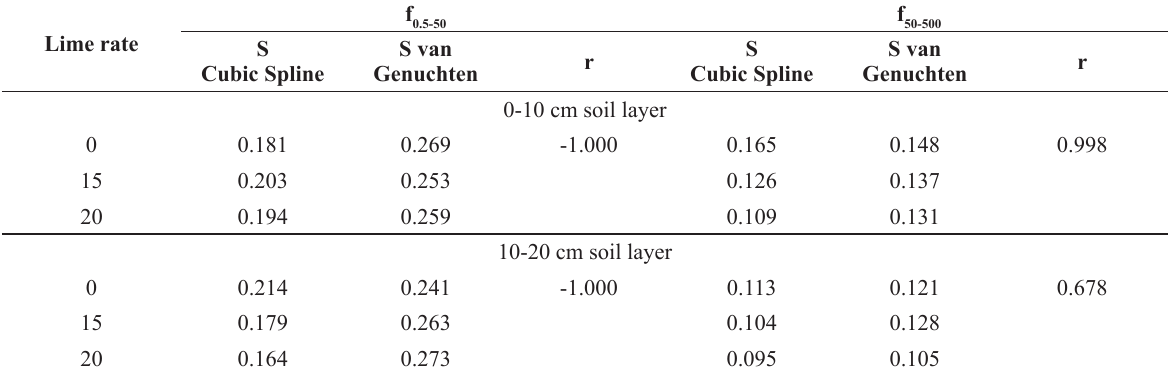
Volume data in terms of relative saturation (S) obtained through the cubic spline and van Genuchten adjustments, for and f classes of pore size, and linear correlation coefficients of Pearson (r) considering both adjustments for 0-10 f 0.5-50 50-500 cm and 10-20 cm soil